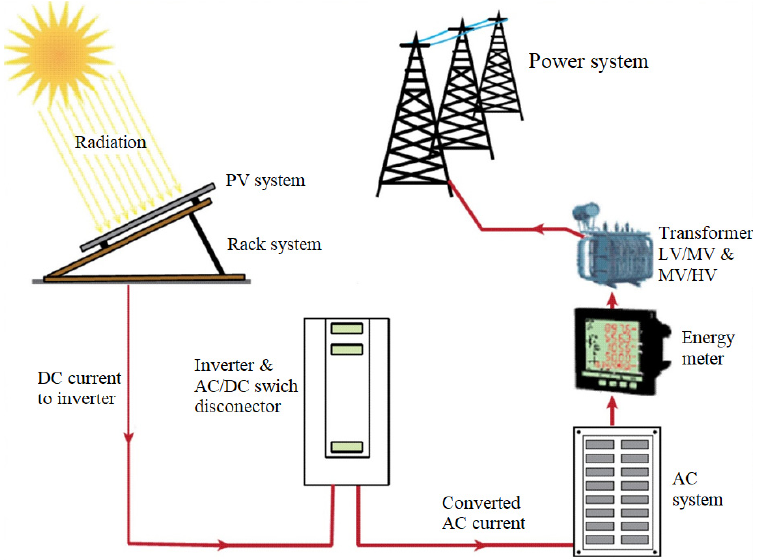
Figure 2. Overview diagram of grid-connected PV plant.